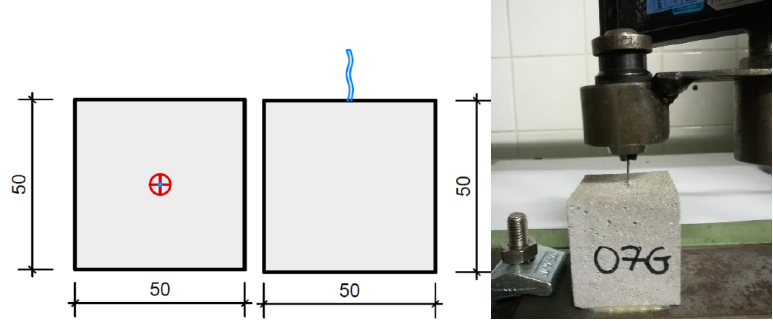
Figure 5. Pull-out tests of the wire fibers: schematic overview ( left ) and sample ( right